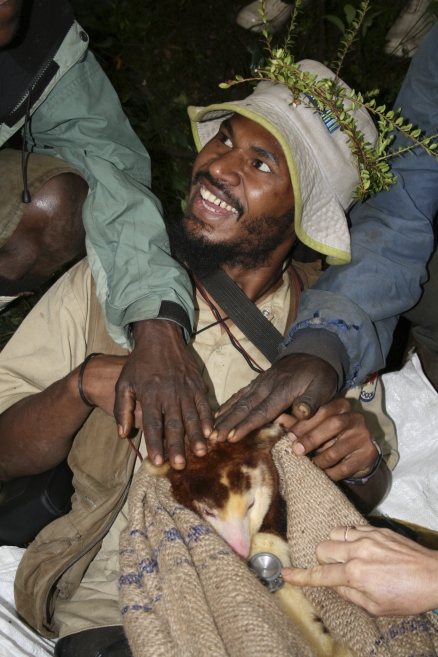
Gabriel Porolak of PNG prepares to outfit a tree kangaroo with a radio collar.(Image: TKCP)